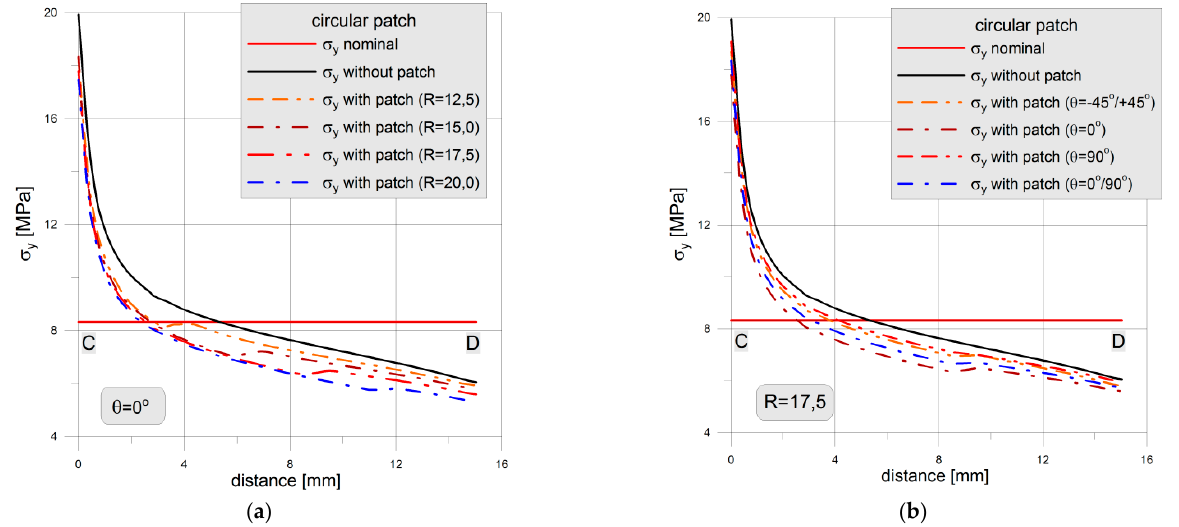
Figure 27. Distribution of tension stress σ y for different size of circular overlay for θ =0°: ( a ) for different values of patch outer radius; ( b ) for different angle of fiber orientation.